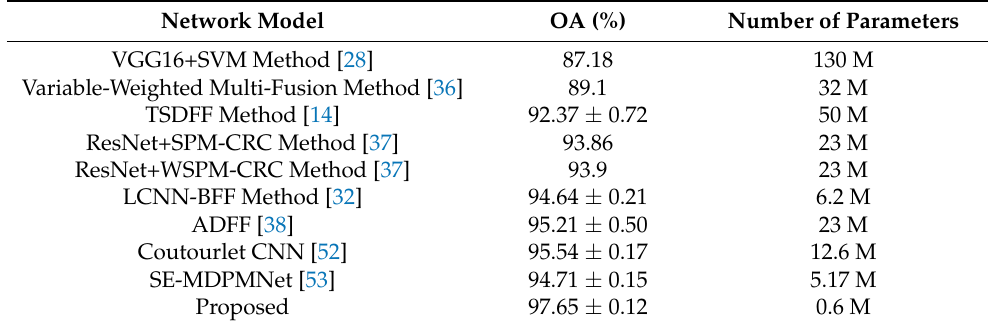
Table 3. Comparison of OA and parameters between the proposed method and some advanced methods on the RSSCN dataset with 50% training ratio.